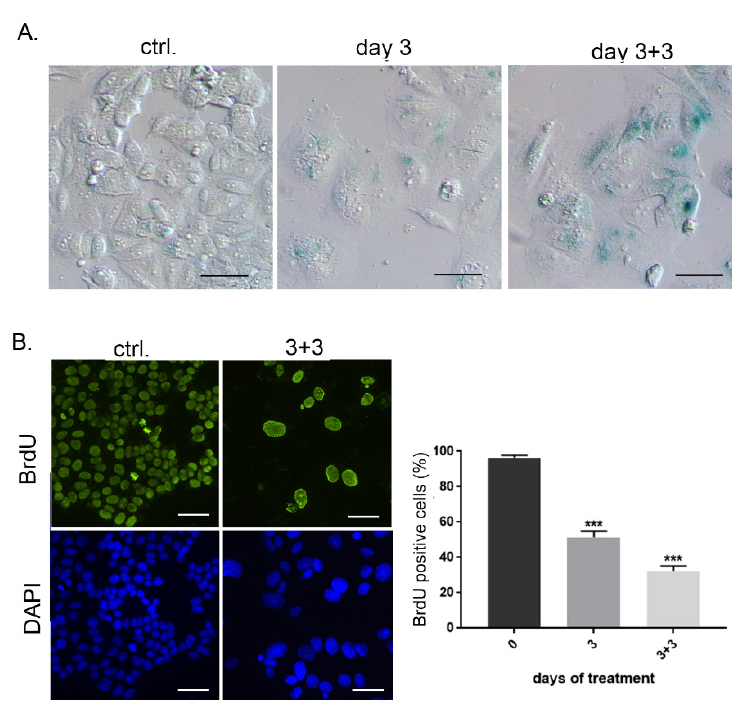
Figure 6. DPI treatment induces senescence of MCF-7 cells. ( A ) Breast cancer MCF-7 were treated with 0.5 µ M DPI for 3 days and SA- β -gal activity was analyzed at indicated time points; ( B ) BrdU incorporation test was performed in untreated and DPI-treated cells and the percentage of cells that were able to incorporate BrdU within 24 h of culture is presented on the graph (mean ± SD, three experiments); *** p ≤ 0.001.